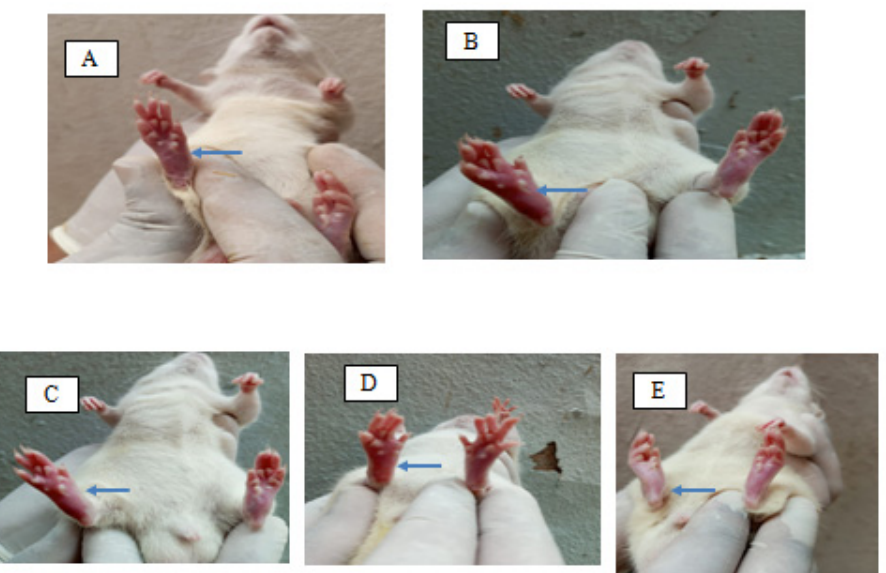
Figure 9. Visual observation of rat during the study of oedema: ( A ) control, ( B ) formalin-induced oedema, ( C ) ethosome suspension, ( D ) gel, and ( E ) standard. Arrow indicates the oedema of each group of rats on the left hind paw.